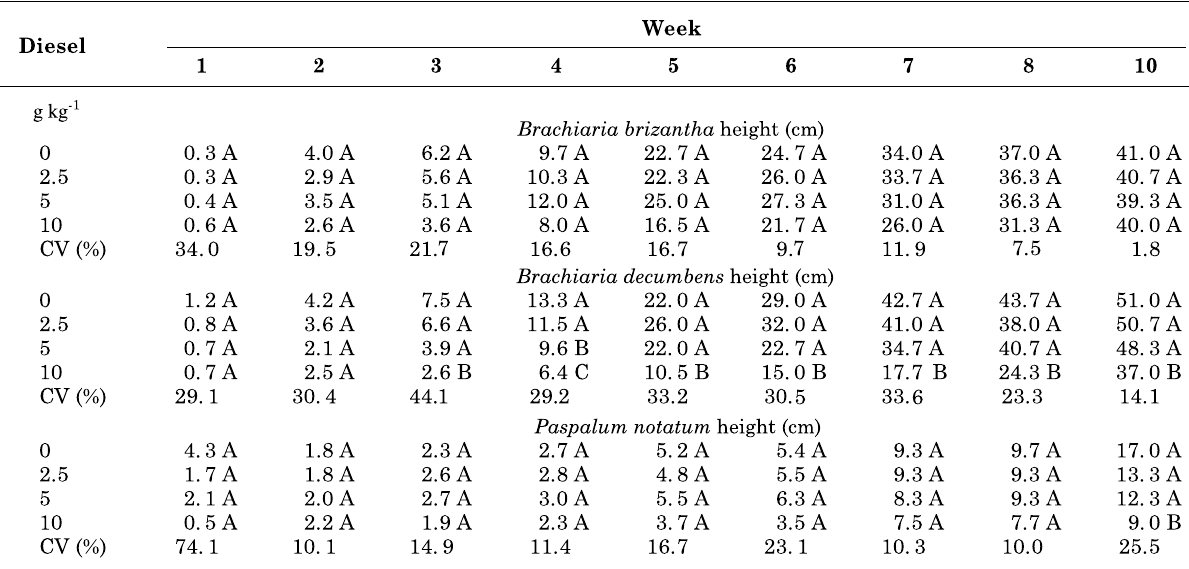
Table 3. Plant height (cm) of Brachiaria brizantha , B. decumbens and Paspalum notatum grown on control